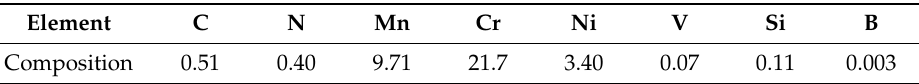
Table 1. The chemical composition of stainless steel used in the present study (wt.%). Element C